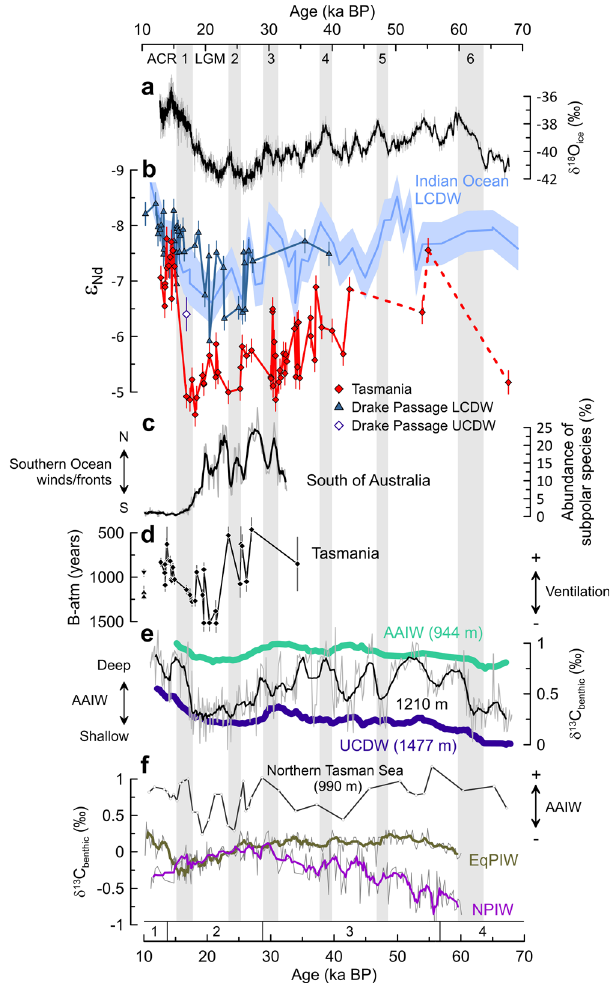
Fig. 3 Mid-depth Nd isotope evolution south of Tasmania in paleoceanographic context. a WAIS Divide ice core oxygen isotope ( δ 18 O) data (thin gray line) with a fi ve-point running mean (thick black line) 99 . b Mid-depth cold-water coral Nd isotope ( ε Nd ) data from south of Tasmania (this study) compared to Drake passage Lower Circumpolar Deep Water (LCDW) 34 and Upper Circumpolar Deep Water (UCDW) 30 and Indian Ocean LCDW from core SK129-CR2 (light blue) 57,59 . Error bars and light blue shading represent the respective 2 SD